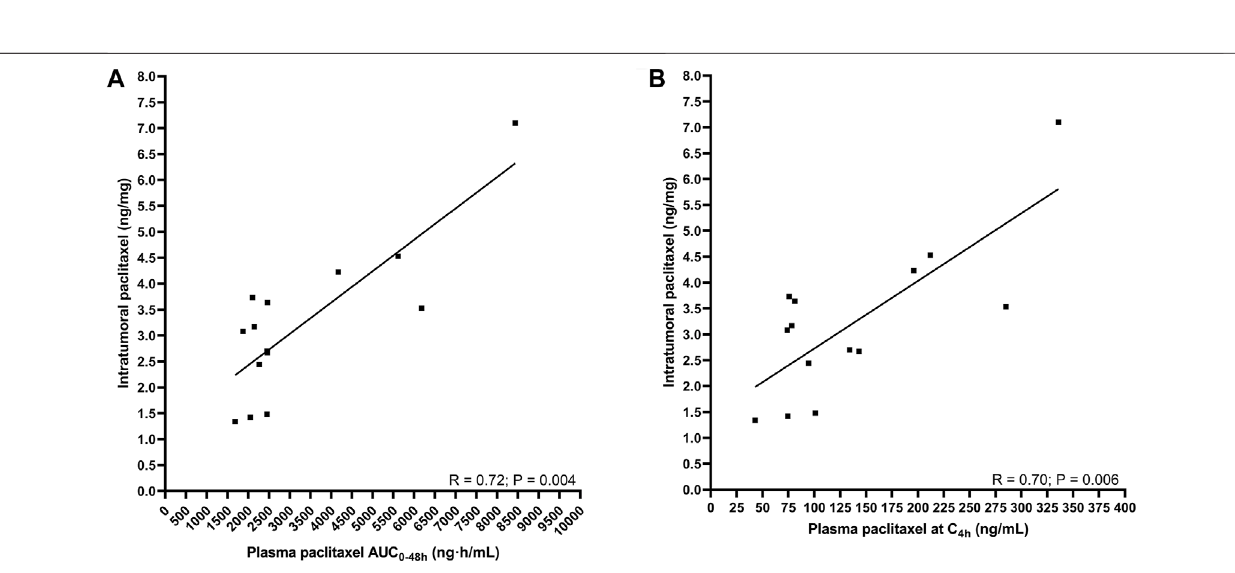
Frontiers in Pharmacology |